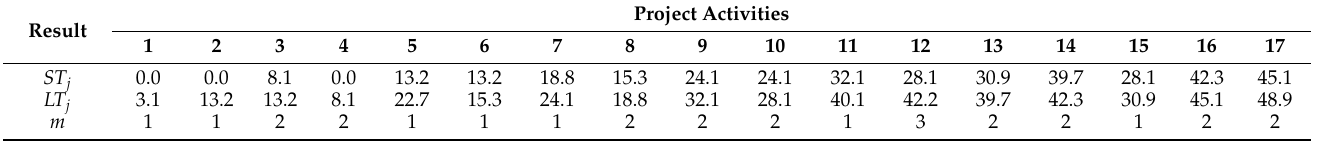
Table 7. MRCPSP calculation